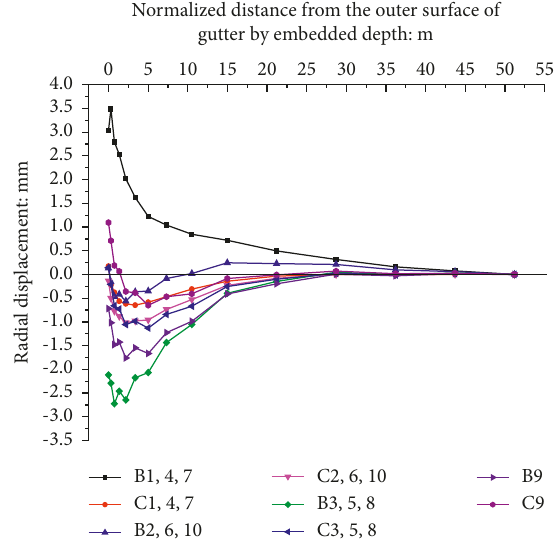
Figure 14: Radical displacement profiles on the ground surface along Gutter 7 during the construction of pane.